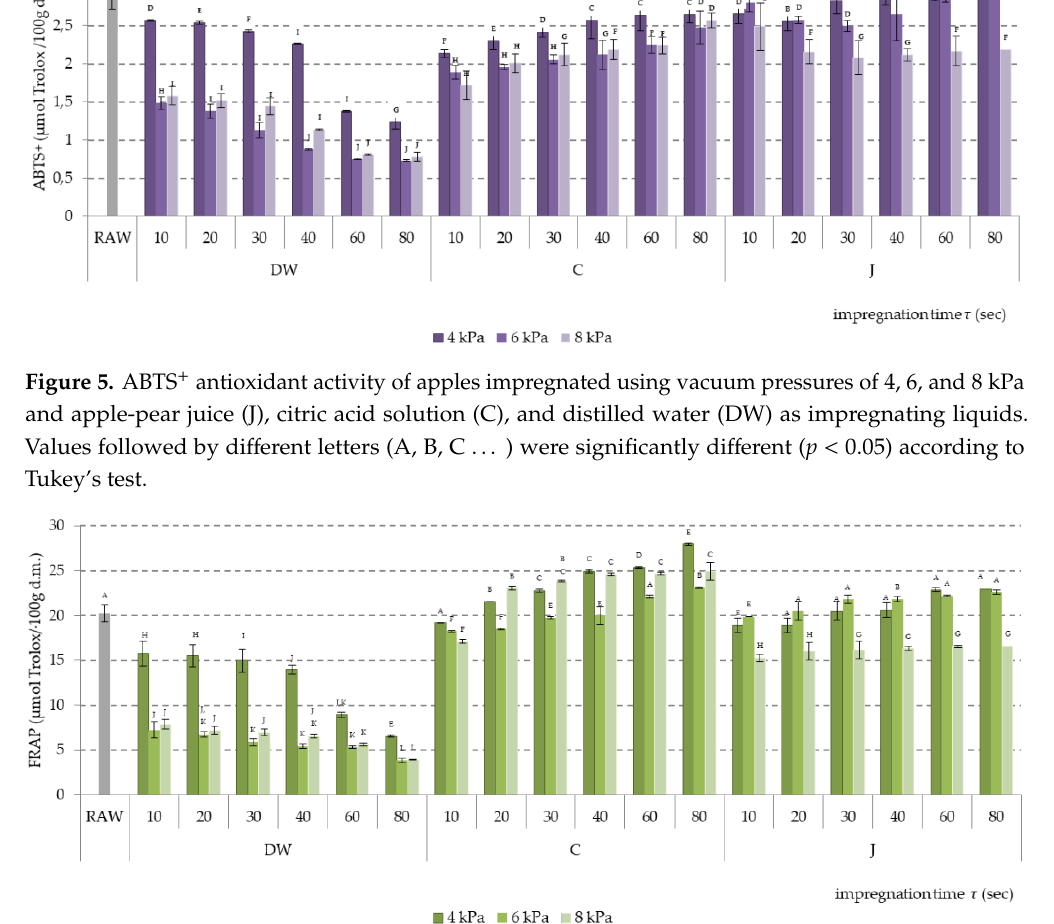
Figure 6. FRAP antioxidant activity of apples impregnated using vacuum pressures of 4, 6, and 8 kPa and apple-pear juice (J), citric acid solution (C), and distilled water (DW) as impregnating liquids. Values followed by di ff erent letters (A, B, C ... ) were significantly di ff erent ( p < 0.05) according to Tukey’s test.